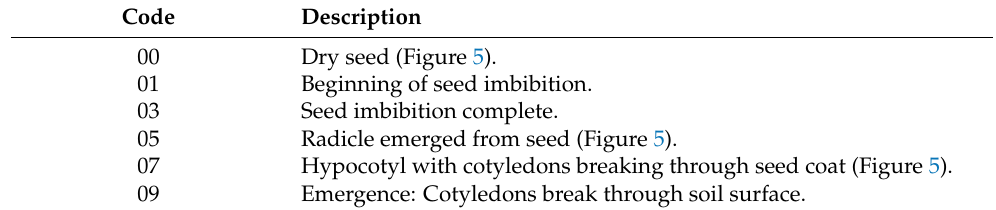
Table 1. Description of main stage 0 (germination) for slender nightshade plants, based on the BBCH